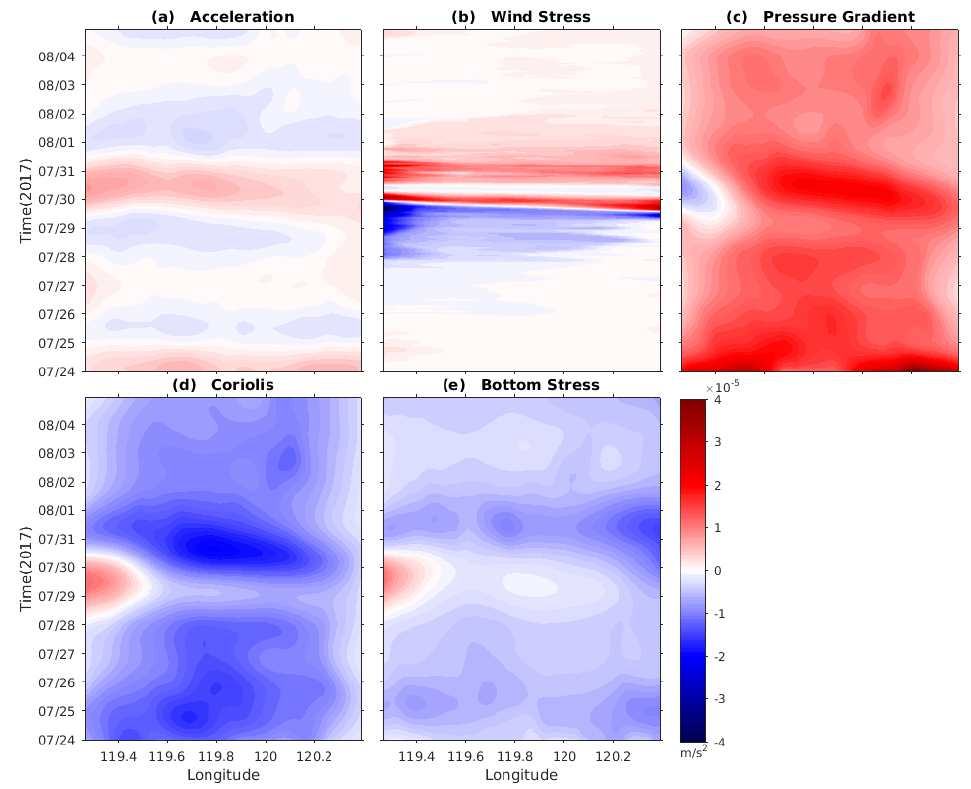
Figure 12. Diagrams of hourly ROMS output of depth-averaged along-shore momentum balance terms (Equation (4)) extracted from the cross-shore section shown in Figure 8f. Extracted variables include ( a ) acceleration, ( b ) wind stress, ( c ) pressure gradient, ( d ) Coriolis, and ( e ) bottom stress. Positive is in the along-shore directions.